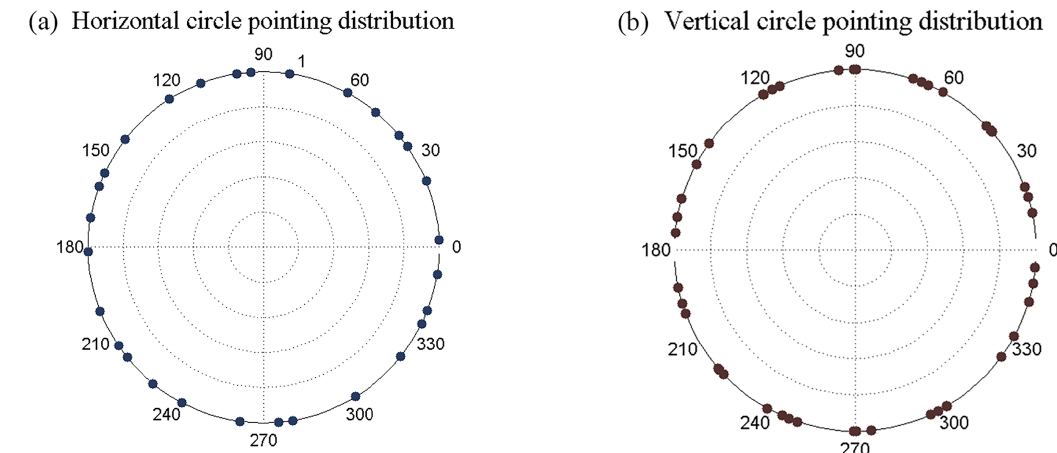
Figure 2. Distribution of pointed direction during ISO-17123 norm validation procedure.